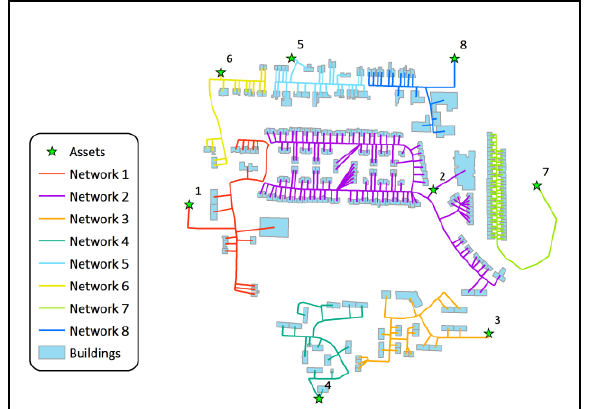
Figure 6. Generated infrastructure network data (Contains OS data © Crown copyright and database right 2018).